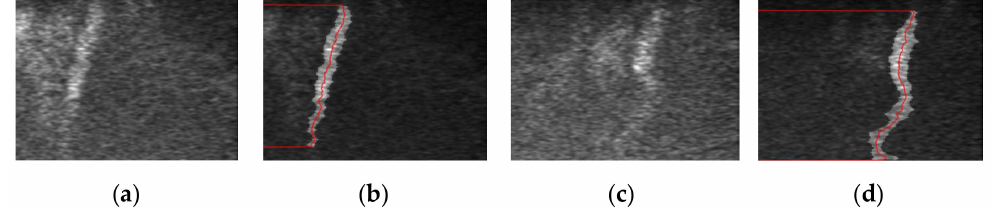
Figure 2. Experimental results of real-time curve tracing. ( a ) The 10th frame image of shear wave propagation in homogeneous region. ( b ) Tracing curve of (a). ( c ) The 30th frame image of shear wave propagation in the region containing a 60 kPa inclusion. ( d ) Tracing curve of